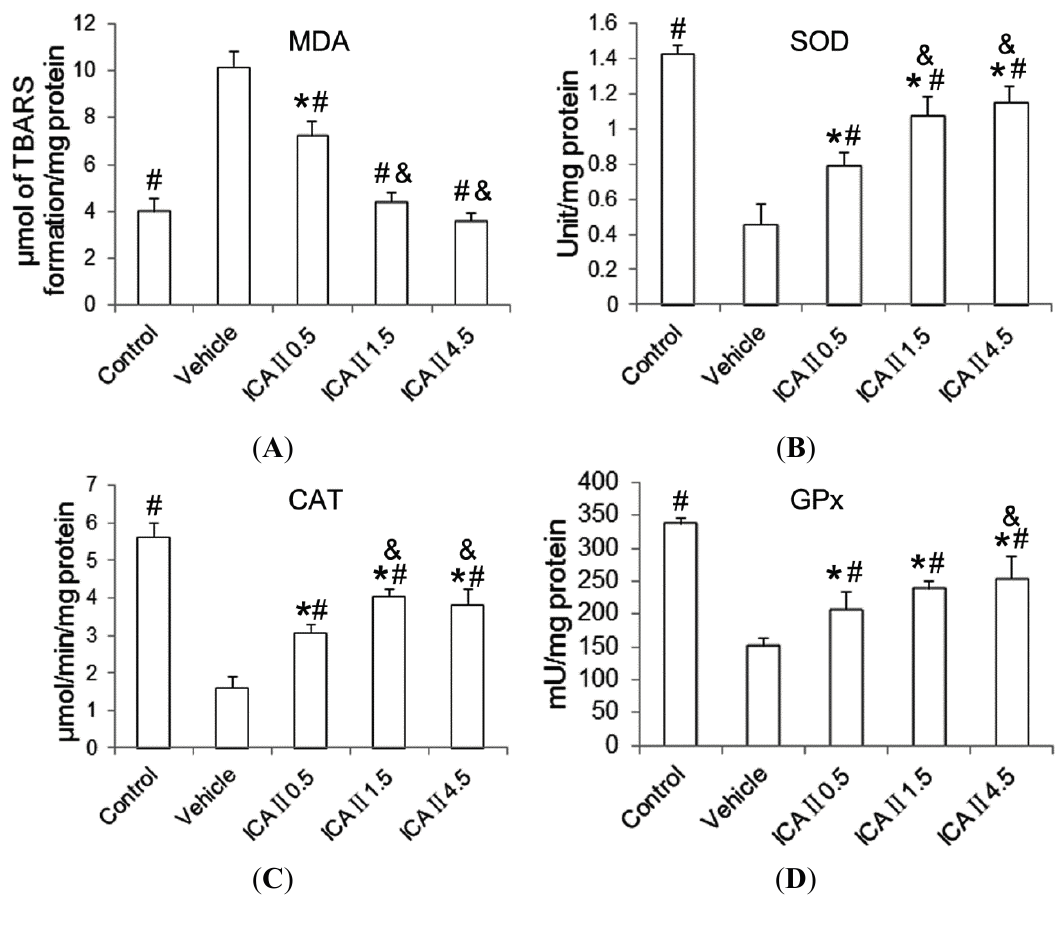
Figure 4. Effects of ICAII treatment on lipid peroxidation (MDA) and antioxidant enzyme activities (SOD, CAT and GPx). ( A ) MDA, Malondialdehyde; ( B ) SOD, superoxide dismutase; ( C ) CAT, catalase; ( D ) GPx, glutathione peroxidase. Values are presented mean ± standard deviation. * p < 0.05 compared with the control group; # p < 0.05 compared with the vehicle group; & p < 0.05 compared with the ICAII0.5